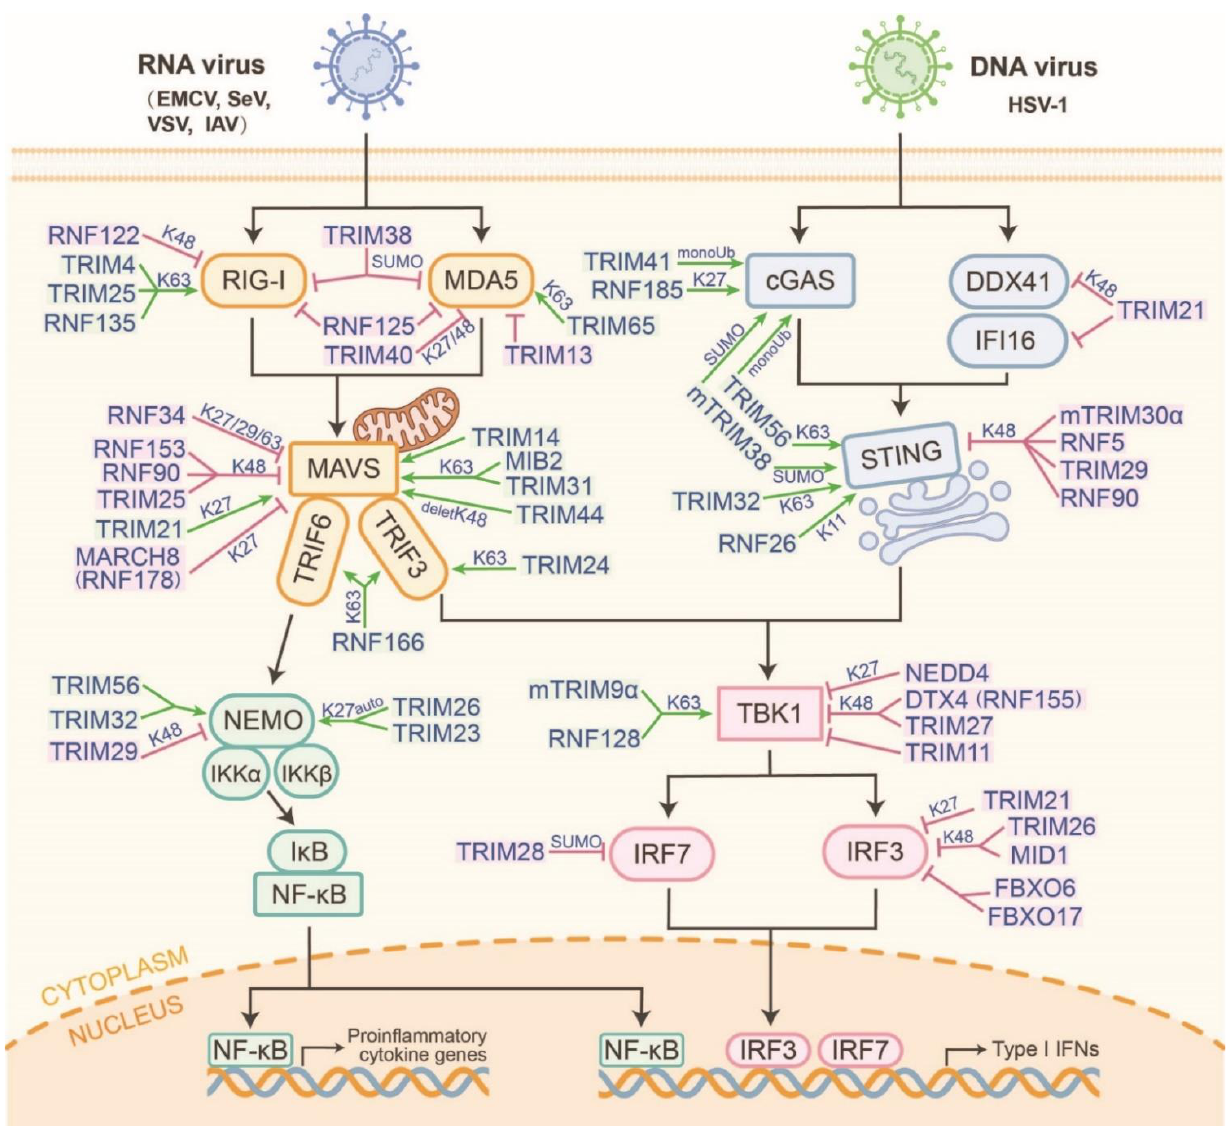
SARS-CoV-2) require further study.